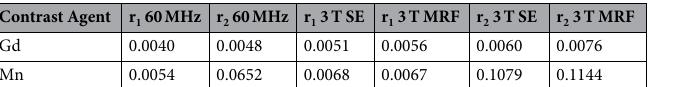
Table S1 Phantom 17). Pure samples with a single contrast agent (either Gd or Mn) were analyzed to increase the number of concentrations calculated and to verify that the method returned a value of 0 if the agent was not present in solution. This comparison resulted in a significant linear correlation (Pearson Correlation: R 2 > 0.998, two-tailed probability p < 0.0001) for both the gadolinium and manganese contrast agents. Importantly, the slopes of these correlations are both near unity (1.003 (Gd) and 0.975 (Mn), respectively) suggesting that the